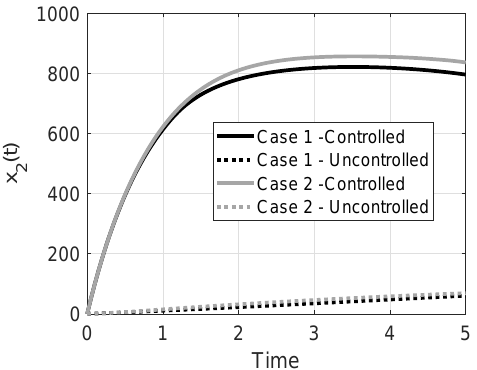
Figure 6. Evolution of the number of x 2 ( t ) subjects in Case 1 (black line) and Case 2 (grey line) with (continuous line) and without control (dotted line).